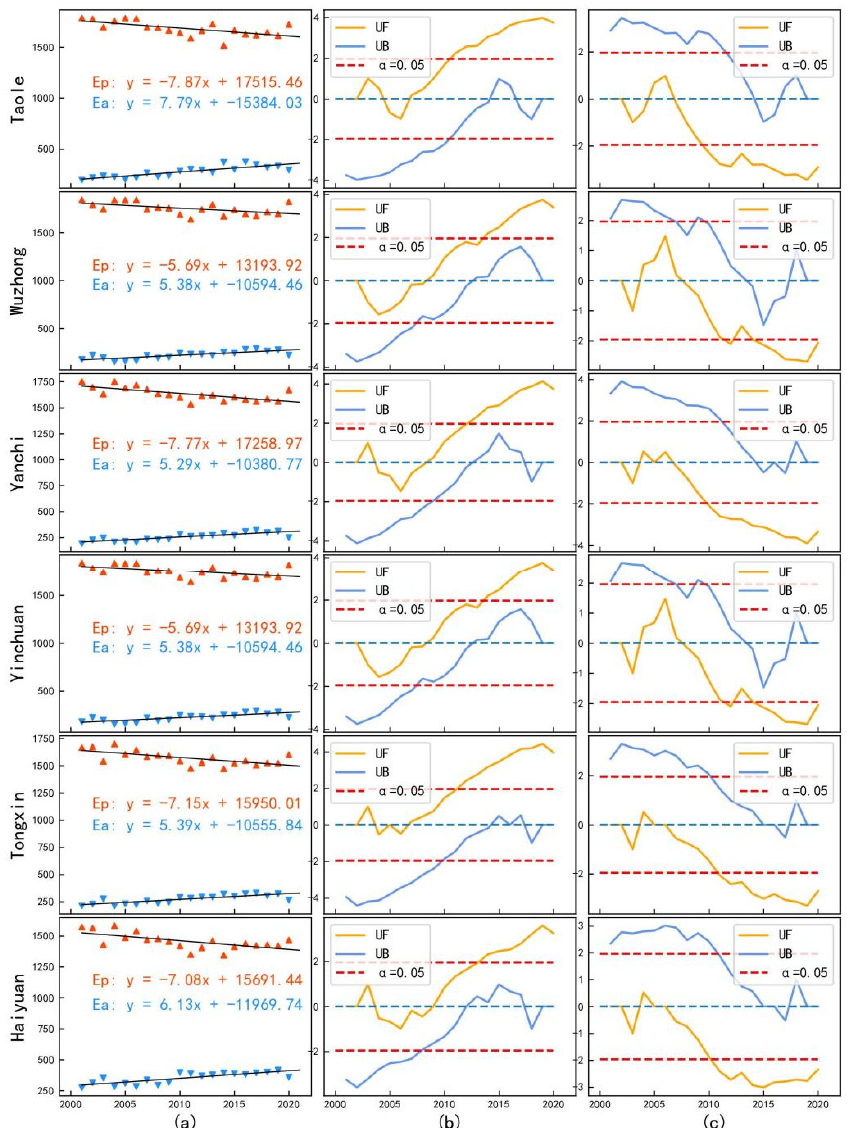
Figure 4. Trend of variation of AET ( ET a ) and PET ( ET p ), and Mann ‐ Kendall test result. ( a ) Variation trends of AET and PET; ( b ) Mann ‐ Kendall test result of AET; ( c ) Mann ‐ Kendall test result of PET.